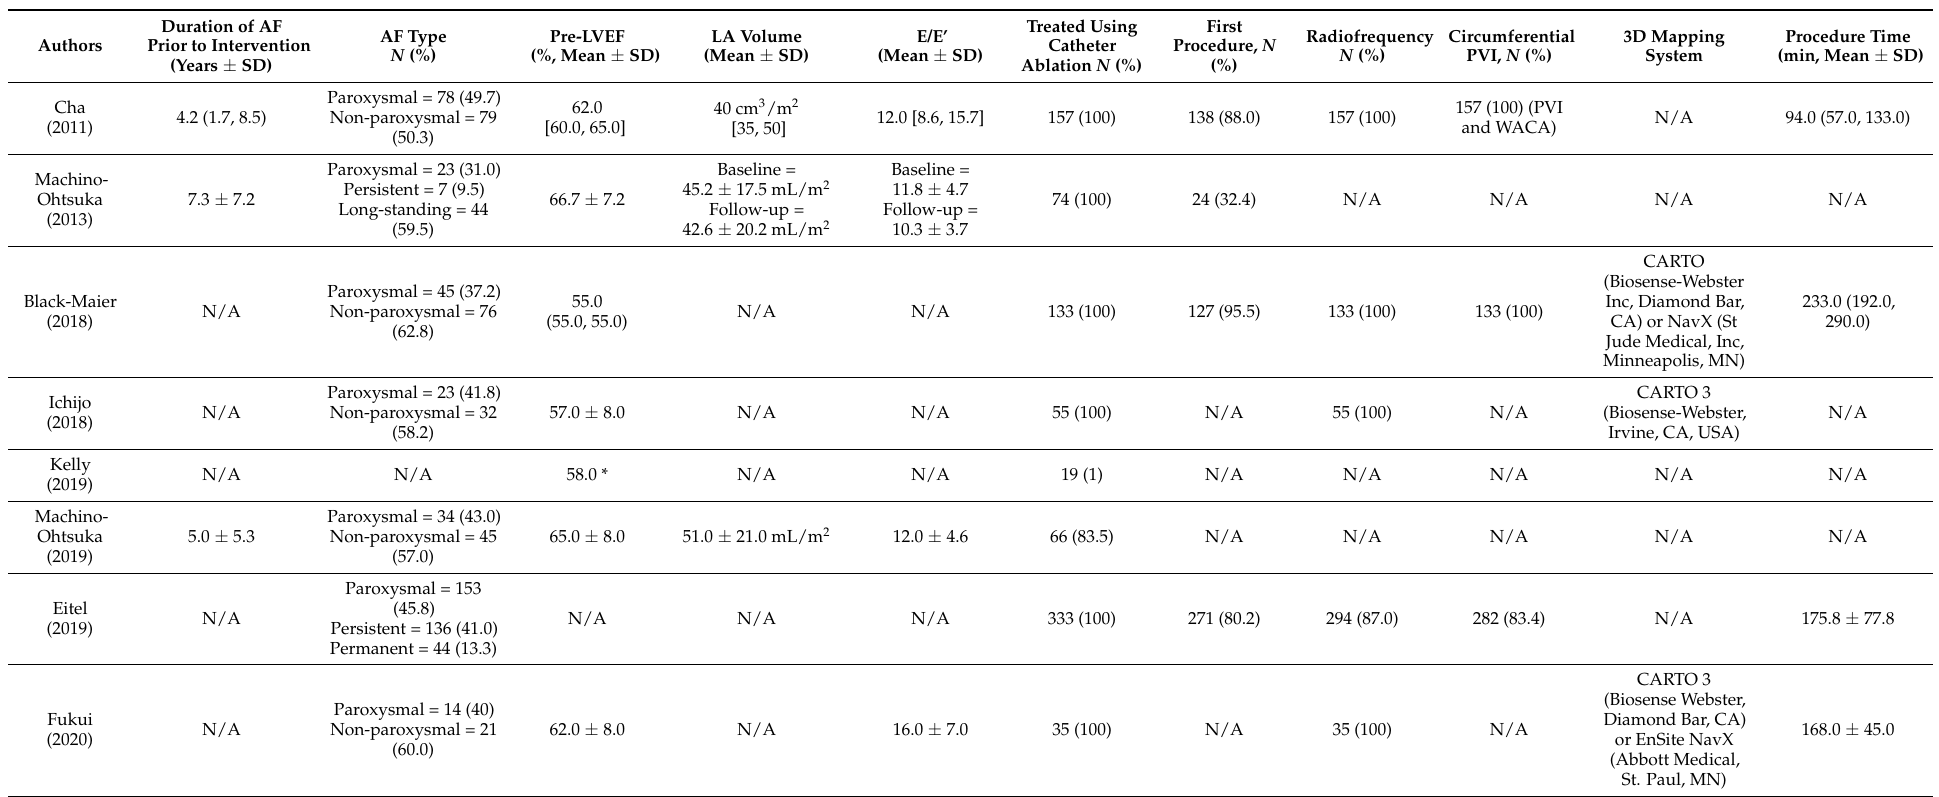
Table 2. Specific procedural and patient characteristics of selected